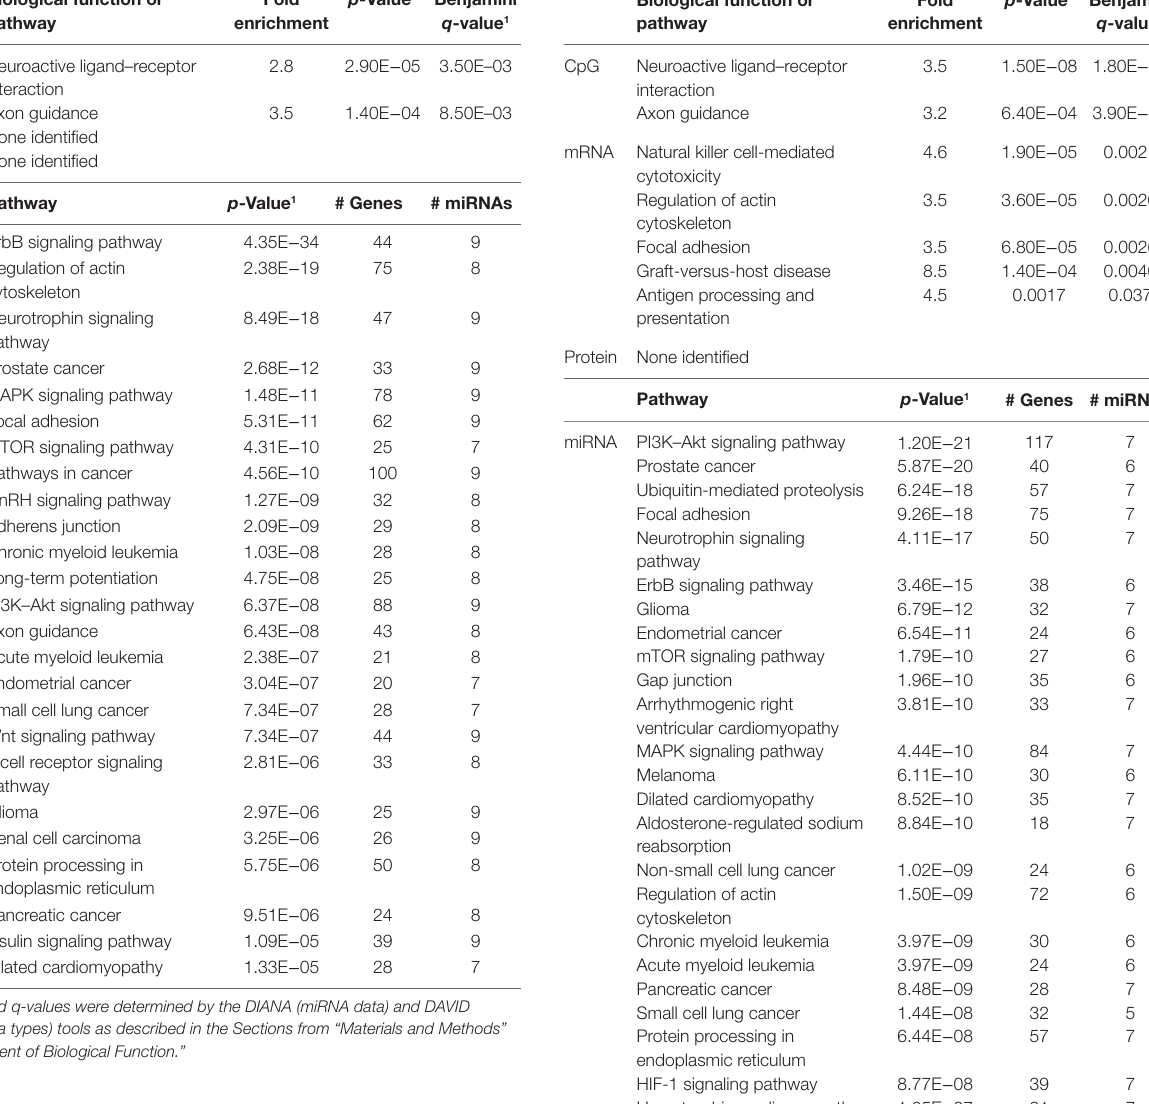
TaBle 5 | Biological functions correlated with the percentage of cD4 + cD28 − cells. Biological function or pathway